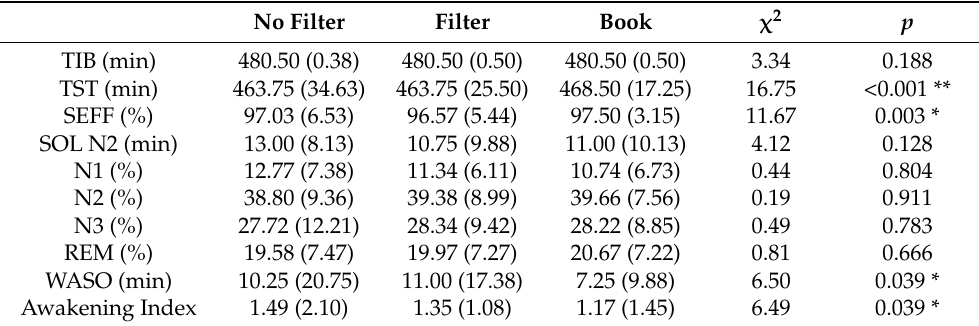
Table 1. Whole night sleep architecture for all conditions (median and interquartile range). Non- parametric Friedman tests were conducted (N = 32).